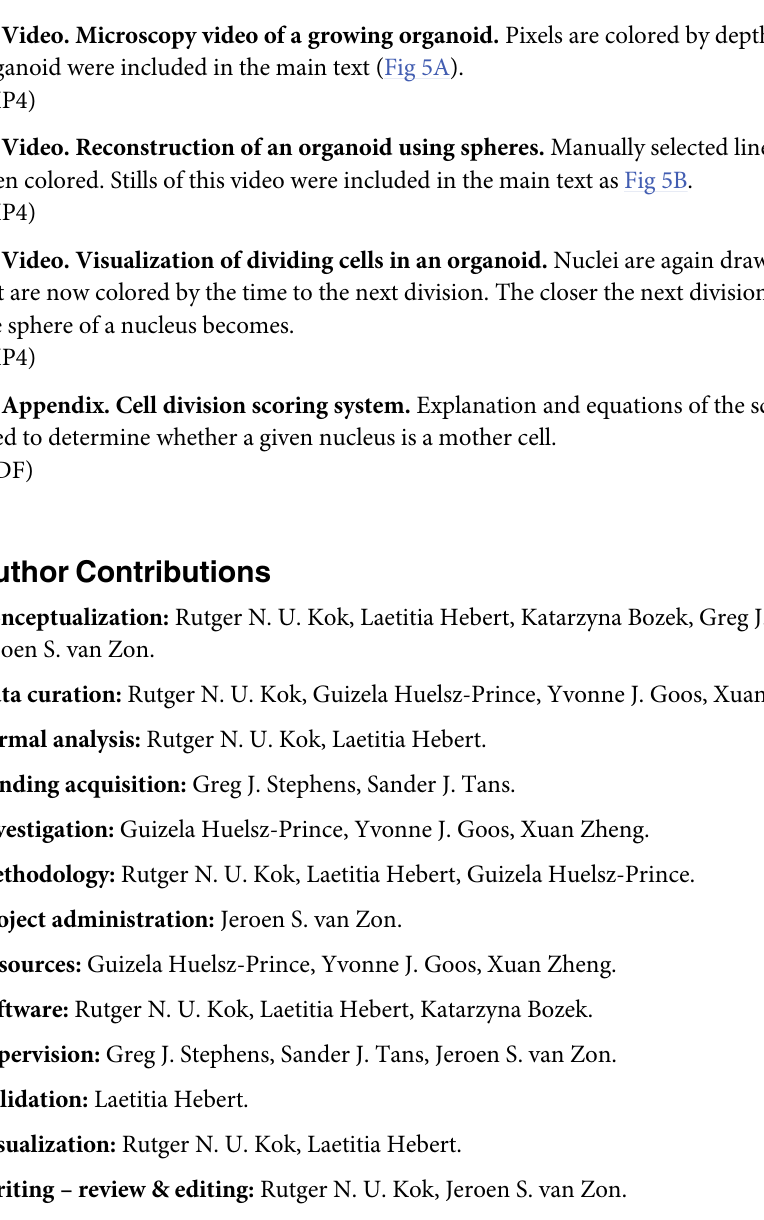
S1 Fig. Full lineages of the manual tracking data of the same organoid displayed in Fig 5. Red crosses denote the positions where a cell death was observed in the microscopy images. This figure will also become part of an upcoming publication.